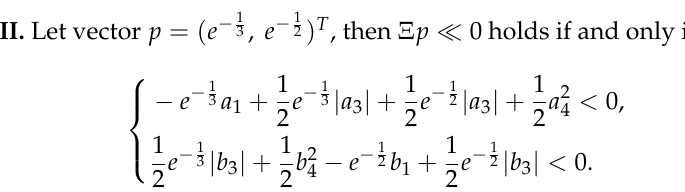
Figure 2. The trajectory of y ( t ) in system